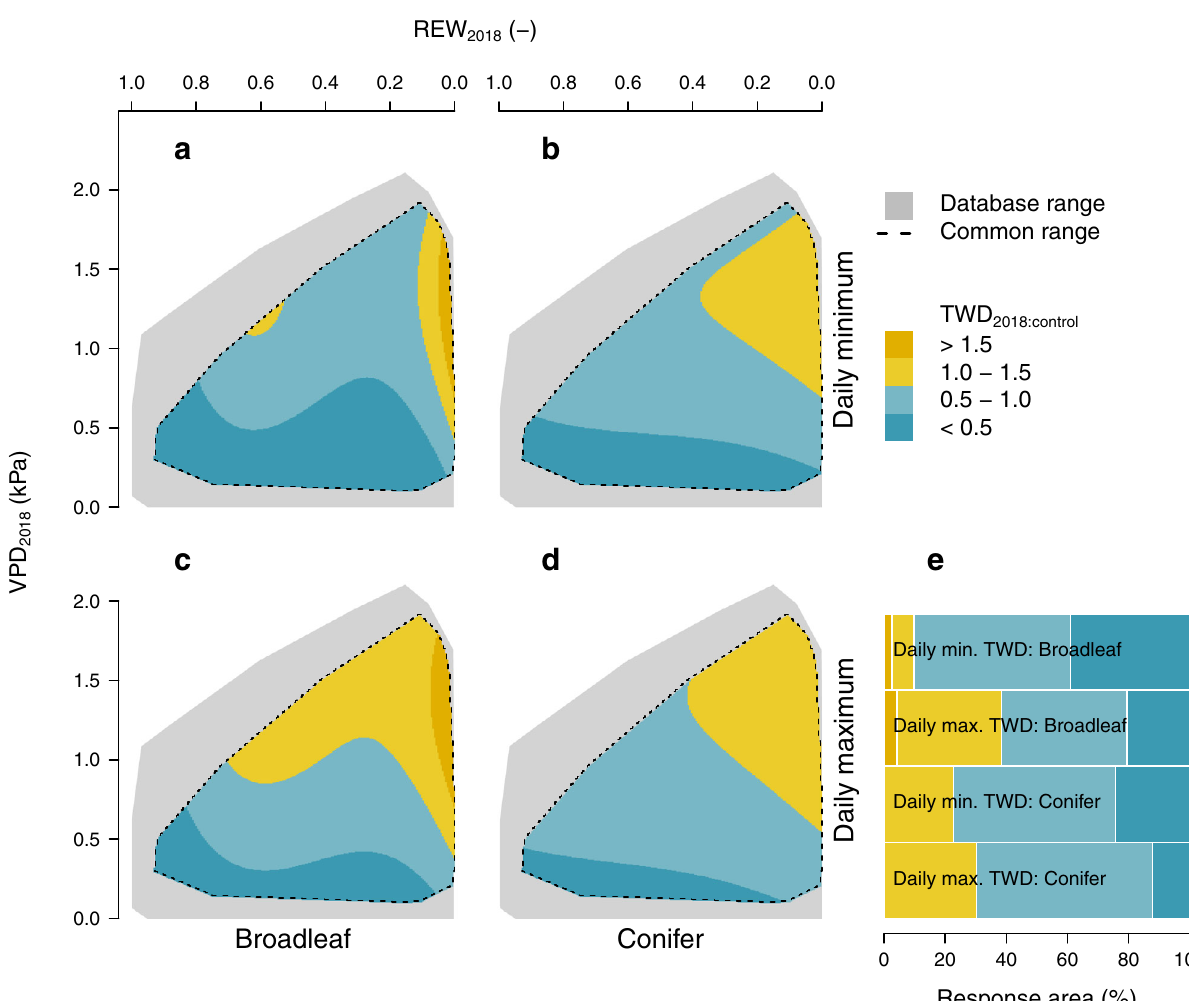
Fig. 3 Response of tree water de fi cit (TWD) ratio to vapor pressure de fi cit (VPD, kPa) and relative extractable water (REW, unitless [-]) of broadleaf (a, c) and conifer (b, d) species in the hydrometeorological space. a – d Linear-mixed effect model output of the ratio of the daily minimum ( a , b ) and maximum ( c , d ) TWD during the 2018 heatwave compared to the 95 th percentile of the control period (TWD 2018:control ), while VPD 2018 and REW 2018 refer to the absolute values during the 2018 heatwave. TWD 2018:control above 1 indicates that a larger shrinkage was registered during the 2018 heatwave relative to the control period. From the hydrometeorological space range of the entire database (indicated in grey), models have been adjusted for the common climatic range of broadleaf and conifer species only (indicated with dotted lines). e Bars indicate the percentage of the hydrometeorological space covering different ranges of TWD 2018:control values (see